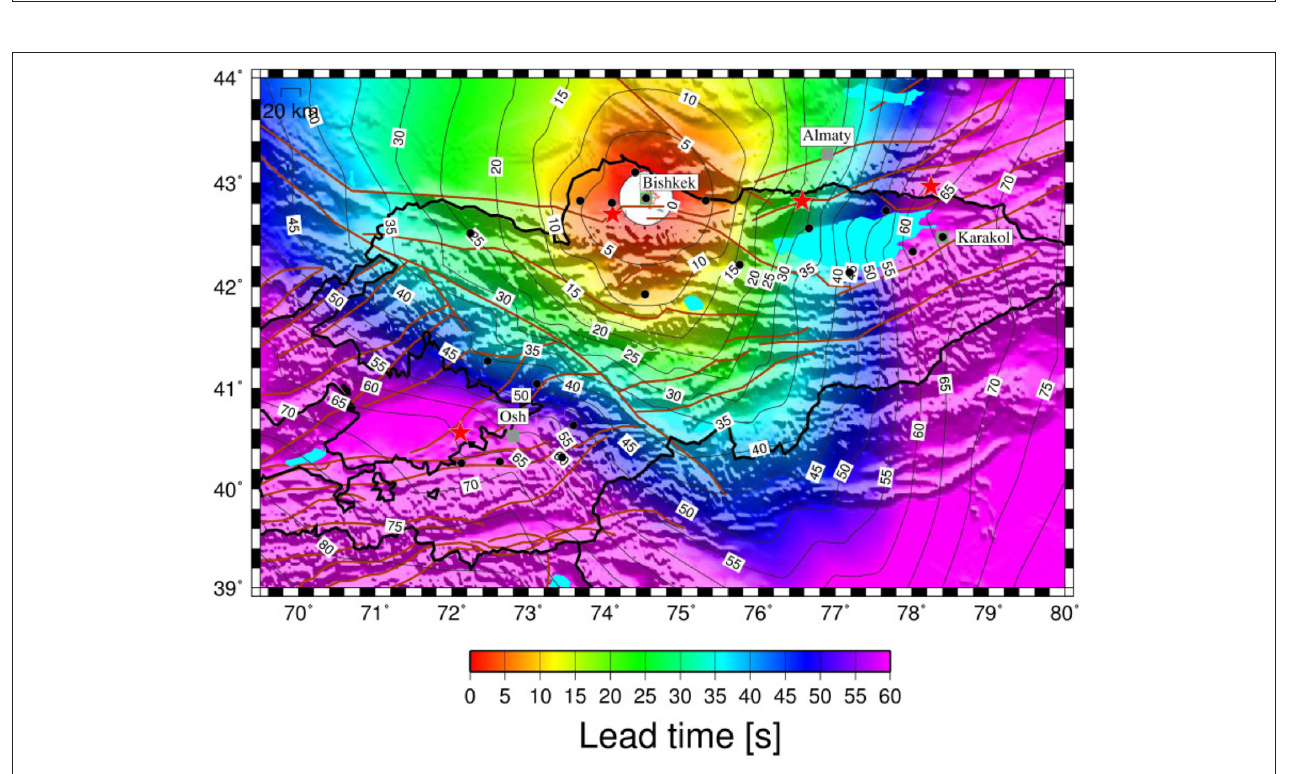
FIGURE 7 | As in Figure 5 , but using a combined regional and on-site approach.